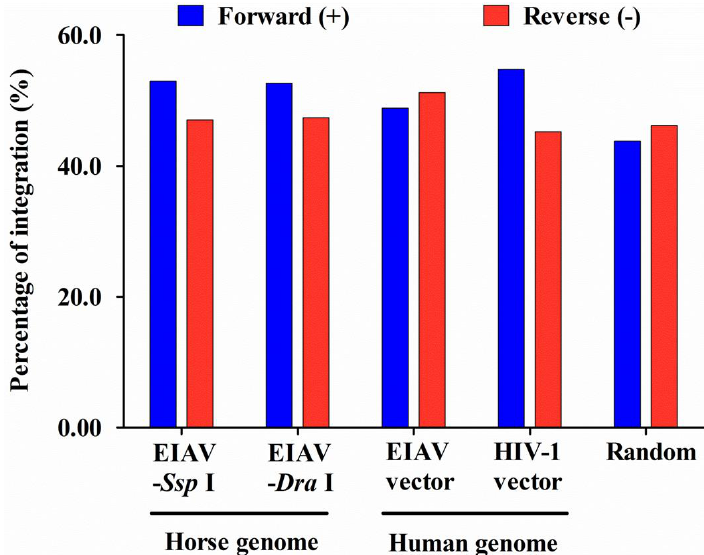
Figure 3. Orientation of the integration sites relative to the TSS. The percentages were calculated according to the total number of integration sites in each type of sample. The chi-squared test was used.